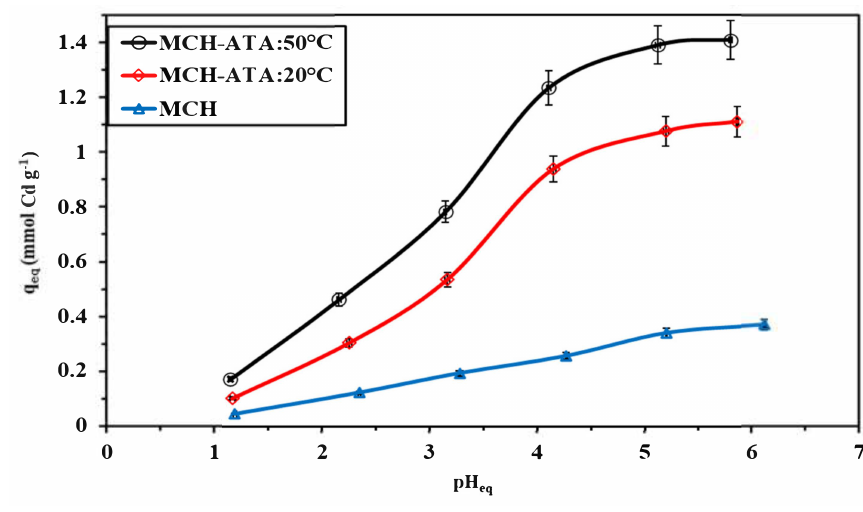
Figure 6. The average values with error bars of the pH effect on Cd(II) sorption using MCH and MCH-ATA at different